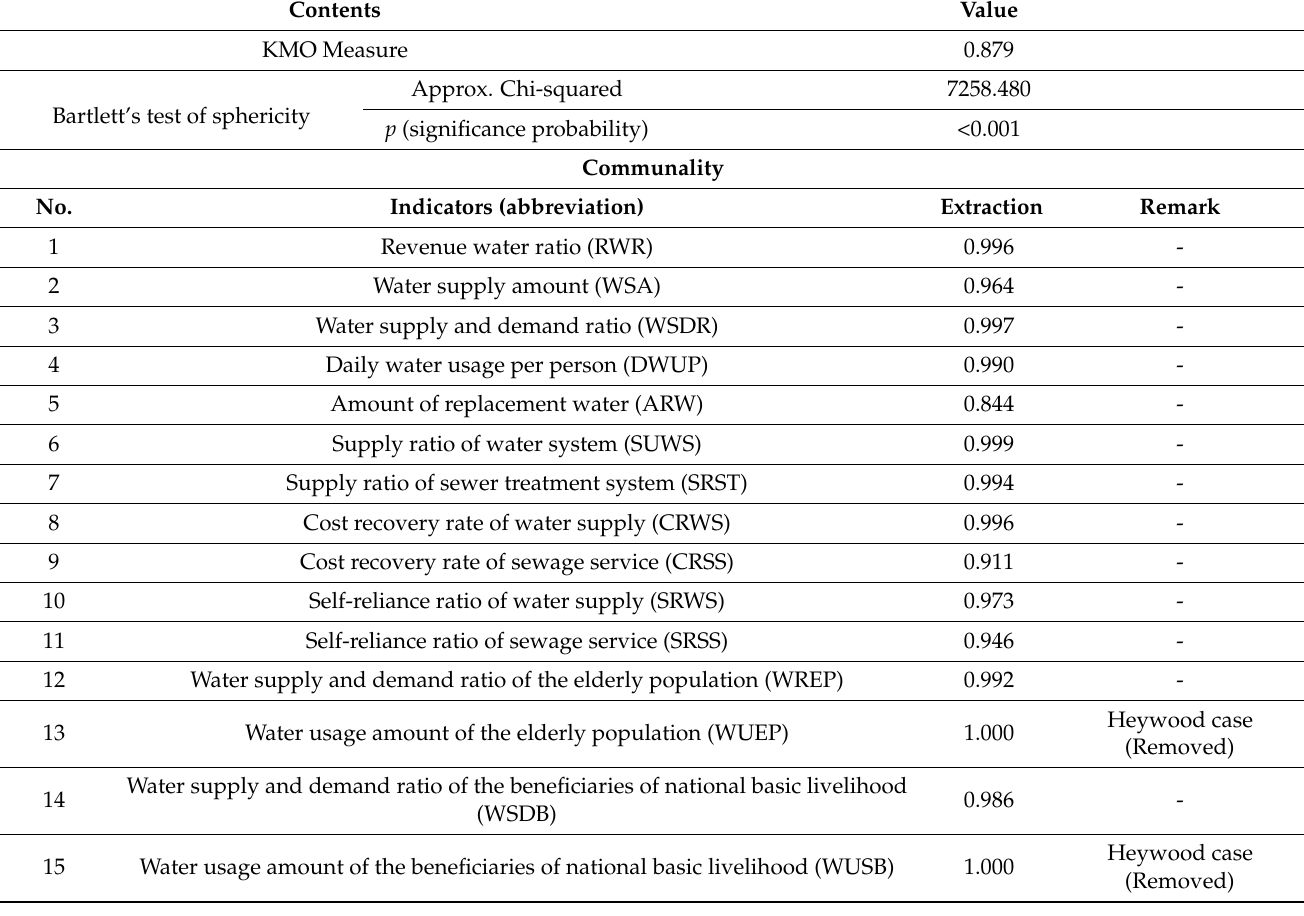
Table 5. Results of Kaiser–Meyer–Olkin (KMO), Bartlett’s test and communality values of the